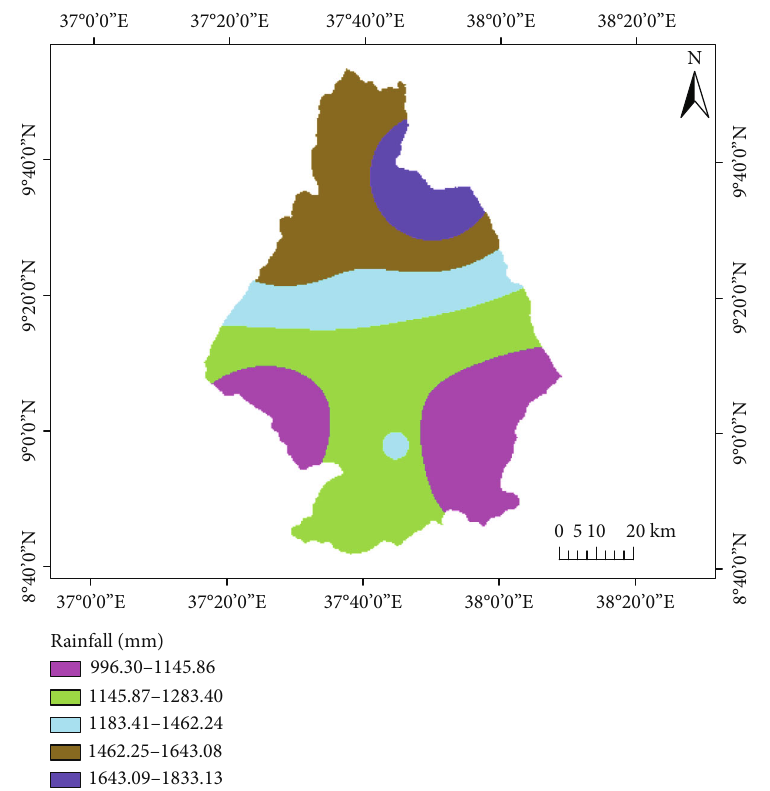
Figure 5: Rainfall map of the Guder watershed.